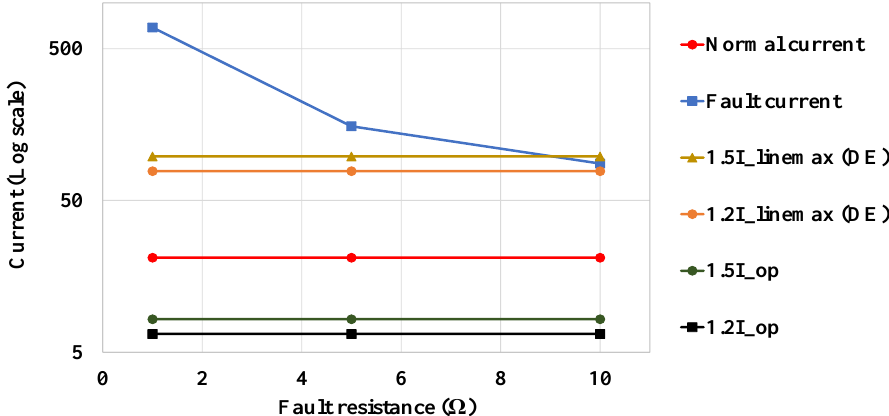
Figure 18. Fault condition with different fault resistances with 70% load and 95% of